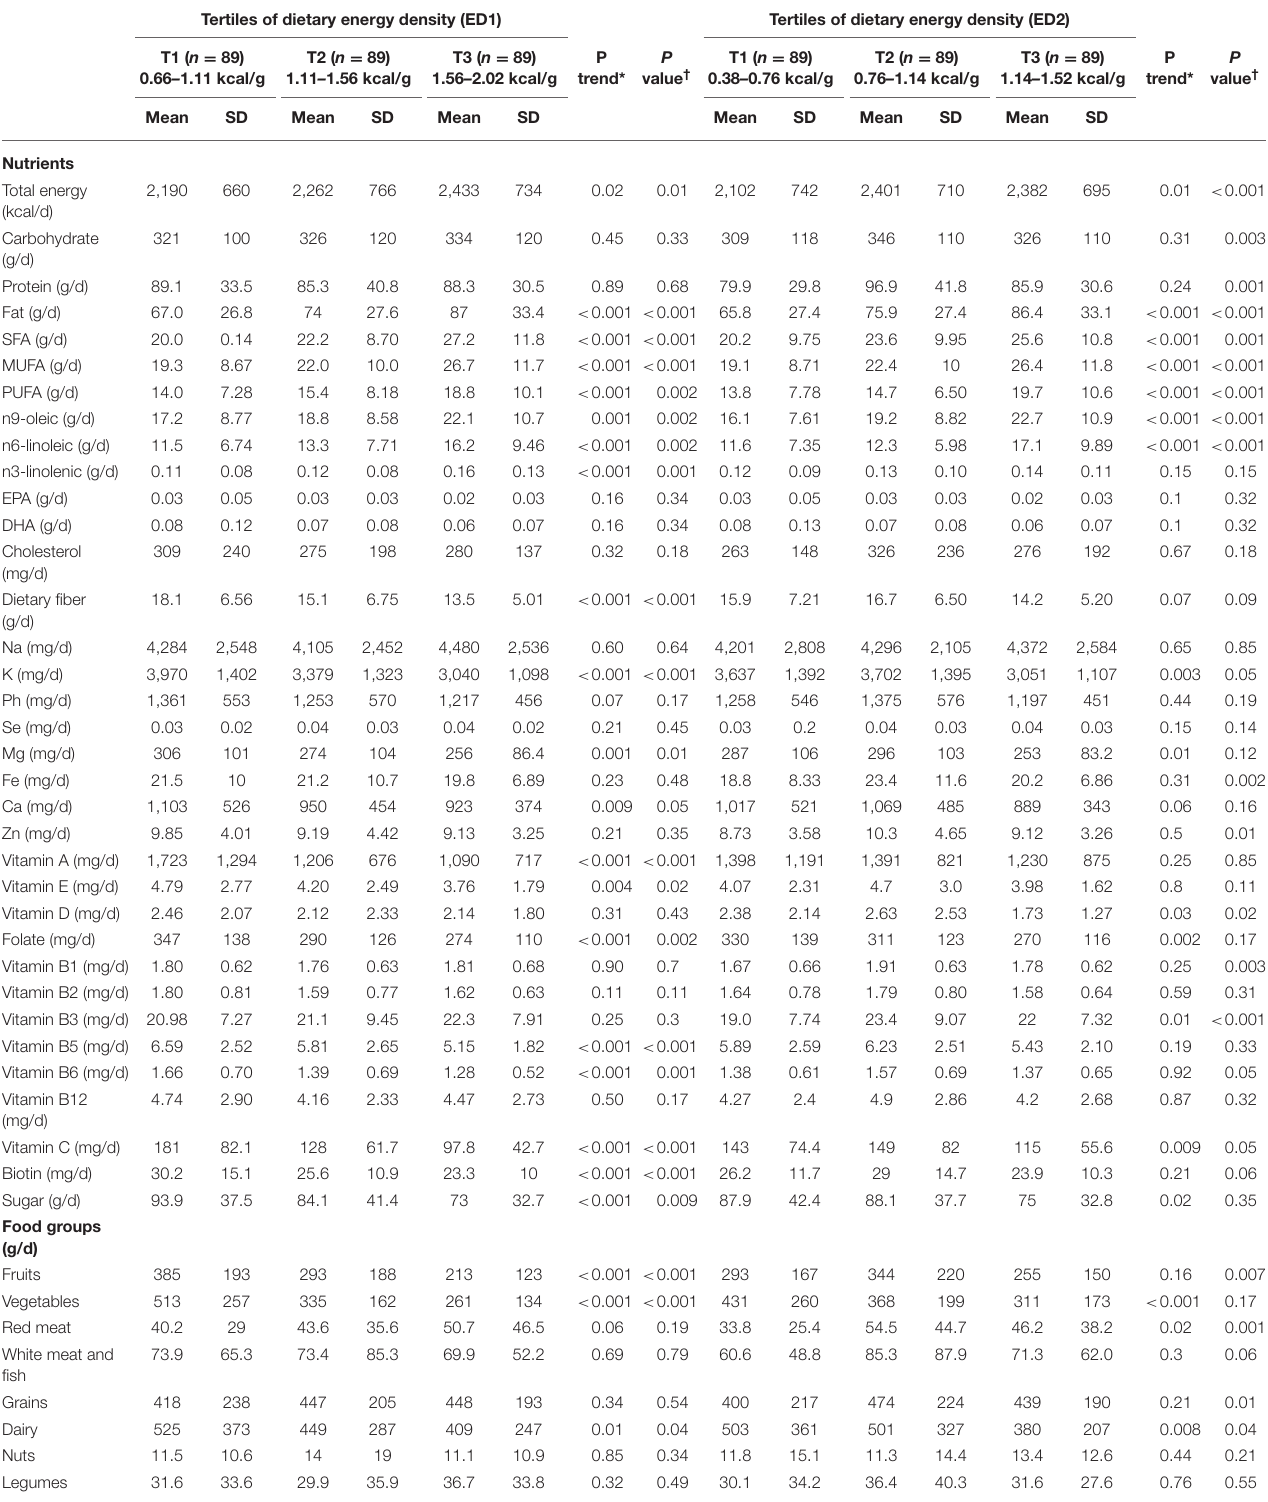
TABLE 2 | Dietary intake of Iranian adults by tertiles of DED. Tertiles of dietary energy density